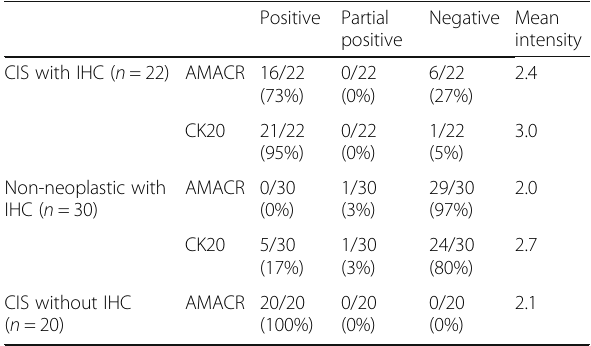
Positive Partial Negative Mean positive intensity